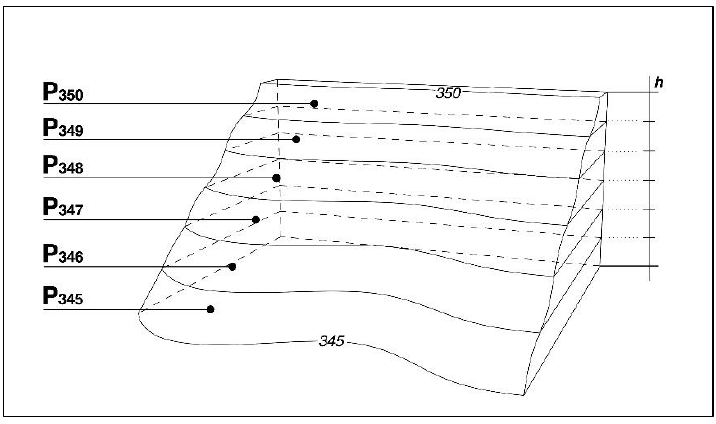
Figure 6. Horizontal sections for computing the volume.